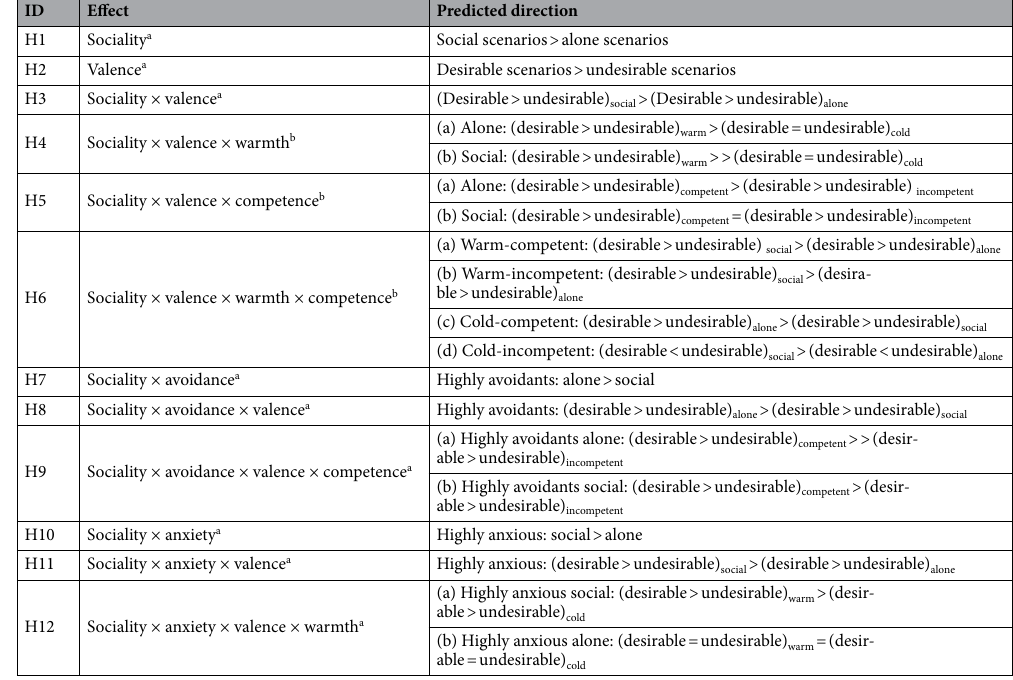
Table 1. List of hypotheses for social optimism. The dependent variable is the likelihood estimate (ranging from 0 to 100%). The superscripts refer to hypotheses that were not supported (a) and supported (b) by the